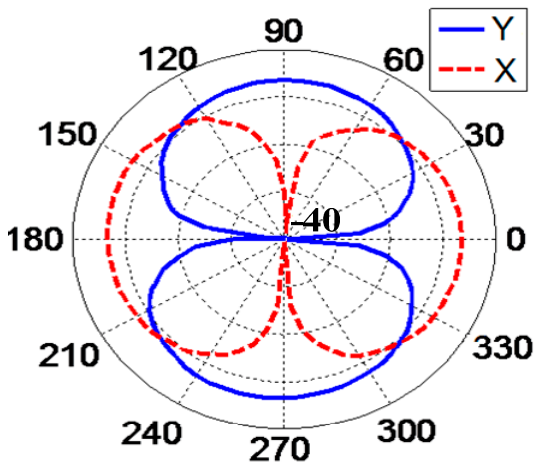
Figure 18. Directivity pattern at a frequency of 500 Hz.